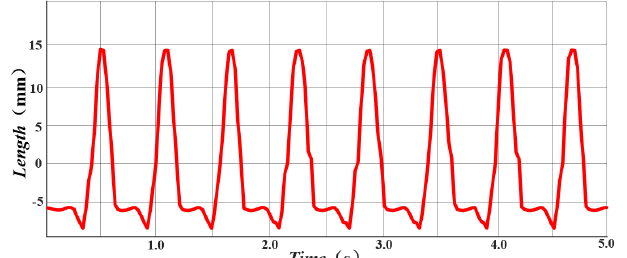
Figure 11. Velocity of the robot’s centroid along the x direction.